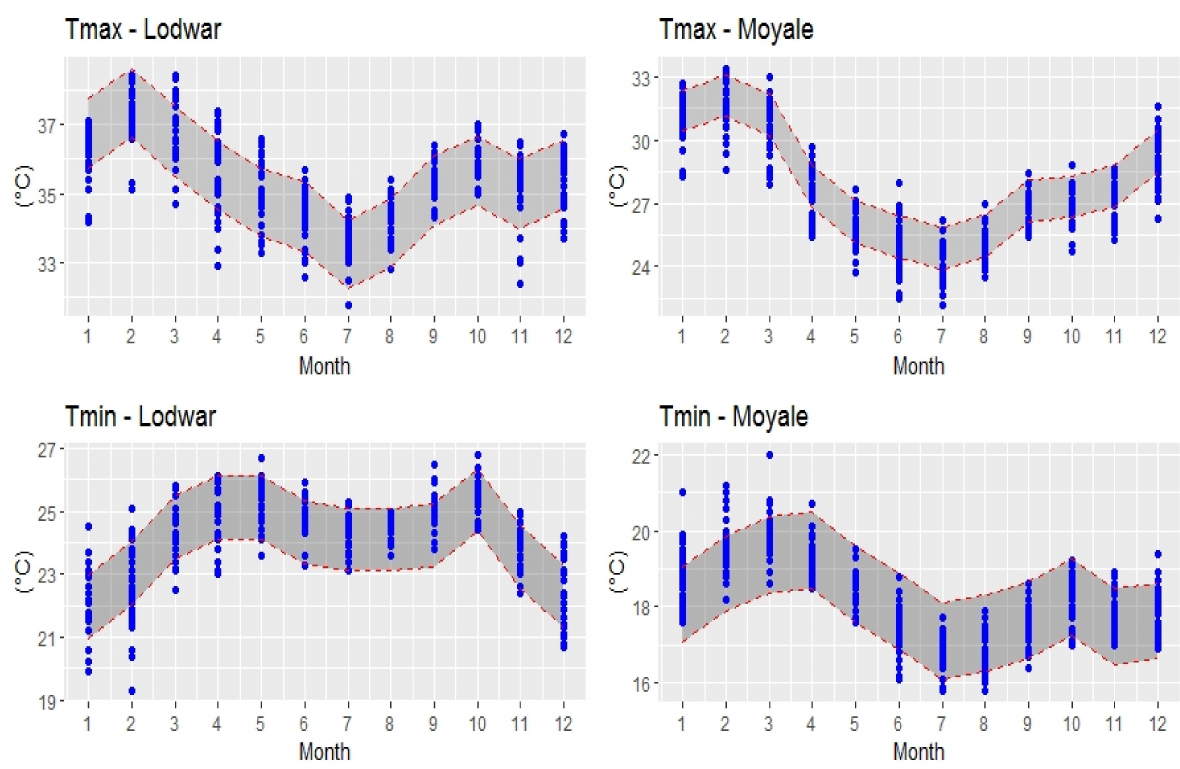
Figure 7. Climatological ranges (gray bands) with an amplitude of 2 ◦ C centered on the monthly mean of the ORH temperature dataset for the selected land-based meteorological stations in the period 1983–2014 (Lodwar and Moyale). Each blue dot represents one monthly observation. Red dashed lines represent the upper and lower limits of the